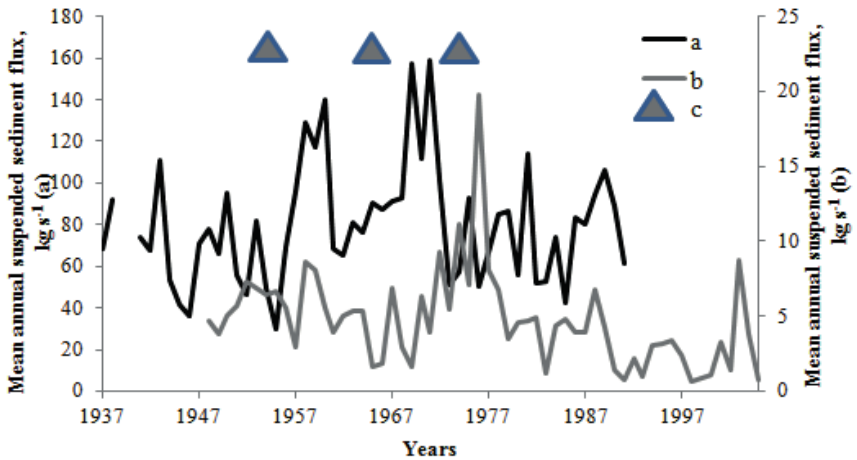
Fig. 4 Relationship between mean annual suspended sediment flux increase and major volcanic eruptions: a – Kamchatka River (Bolshie Sheki hole), b – Tolbachick River (Tolbachick settlement), c – eruptions of Bezymyanny, Shiveluch, and Plosky Tolbachick volcanoes.